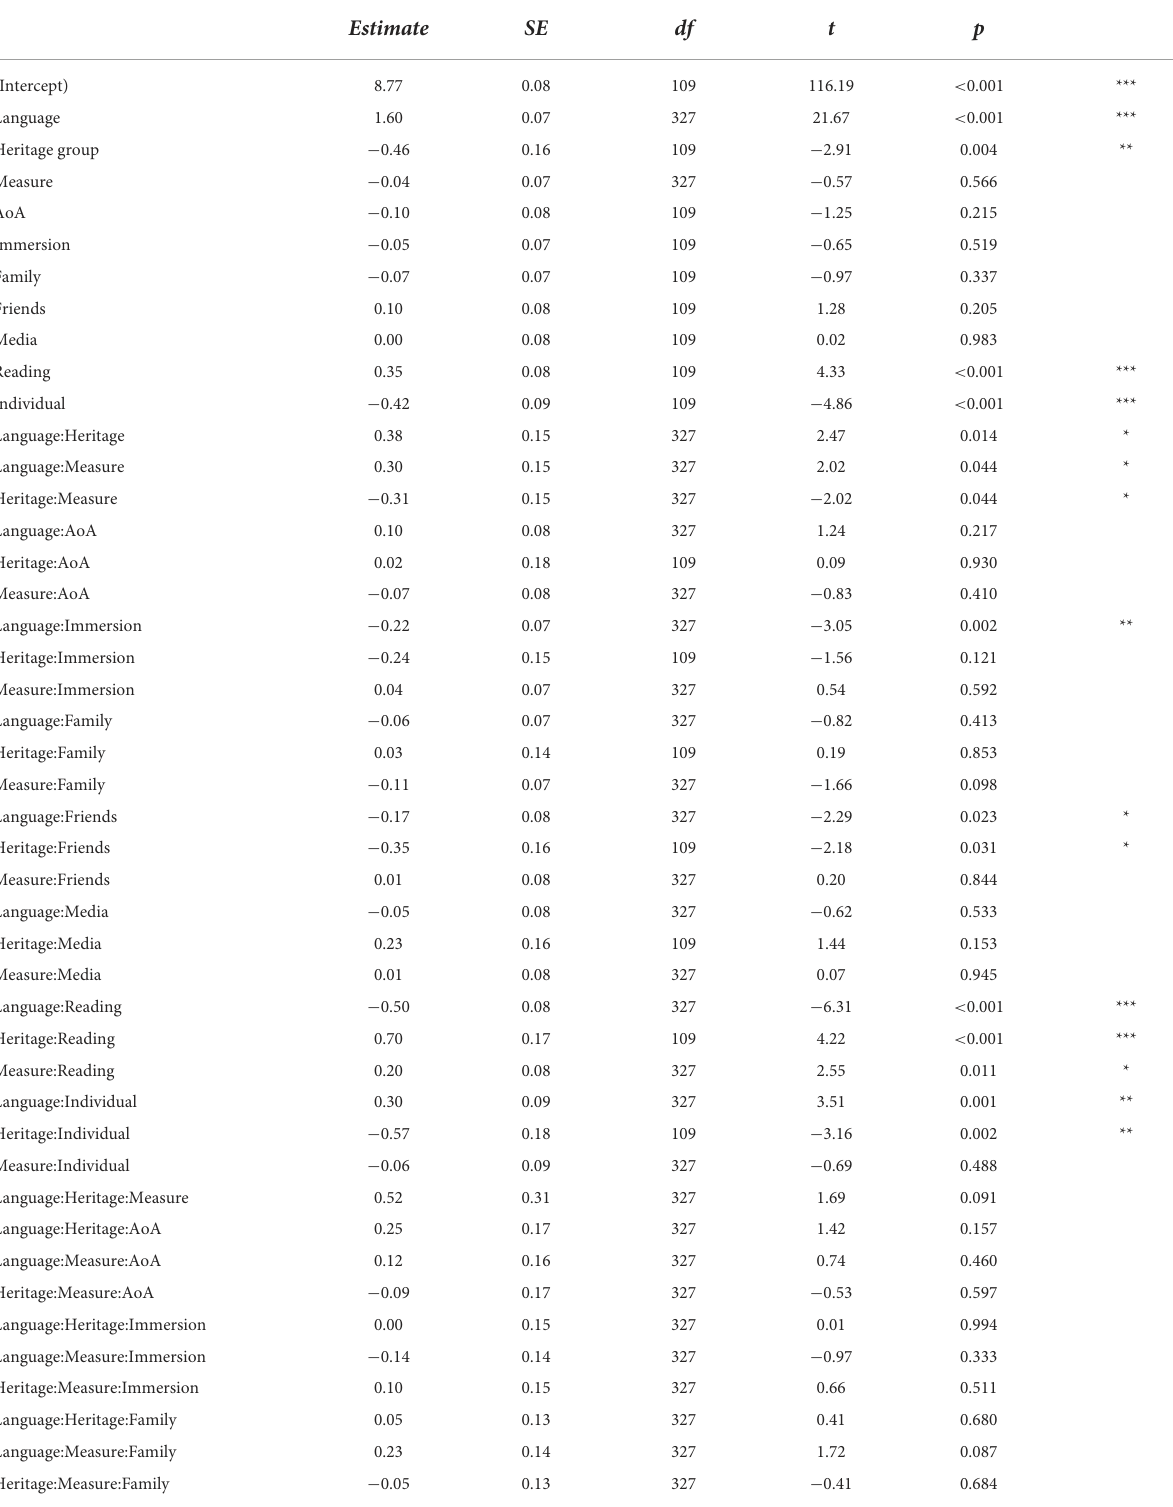
TABLE 2 Effects of heritage language experience on self-reported heritage language and English proficiency. Estimate SE df